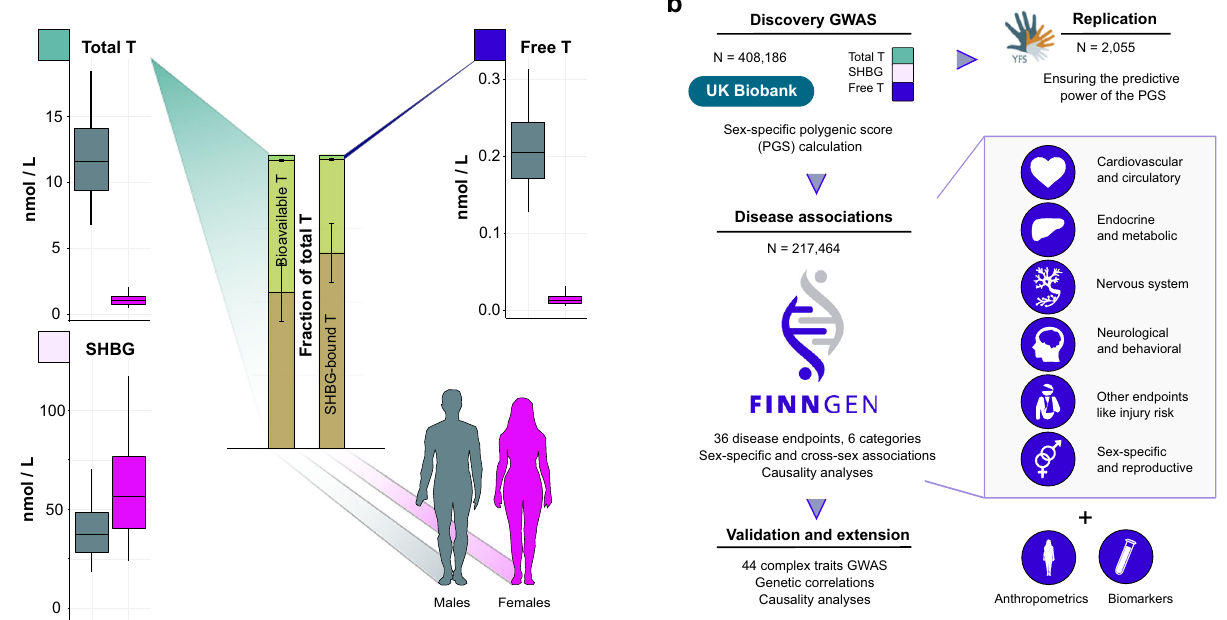
Fig. 1 Illustration of the studied traits and study overview. a The traits subjected to GWAS (total T, SHBG and free T) and distribution of these in the UK Biobank. The barplots illustrate division of serum total T to SHBG-bound (brown), and bioavailable fractions (green) including free T (bright green) for men (dark green) and women (pink). The three boxplots in a show sex-speci fi c distributions for serum total T, SHBG and calculated free T levels for the UK Biobank participants included in the GWAS. These boxplots show median for each trait (black line), lower and upper quartiles (colored area of the box) and the error bars indicate 5 and 95% quantiles. b Overview of the study design to assess the contribution of T to health and disease using genetic approaches and biobank data. We conducted the discovery GWAS in the UK Biobank ( N = 408,186), built sex-speci fi c PGSs for the three T-related traits and validated the predictive ability of the PGSs in the Young Finns Study (YFS) ( N = 2055). We then performed complex disease and trait associations using the PGS in FinnGen (release 5, N = 217,464), complementing these analyses with Mendelian Randomization analyses and extending these analyses with publicly available GWAS data from other